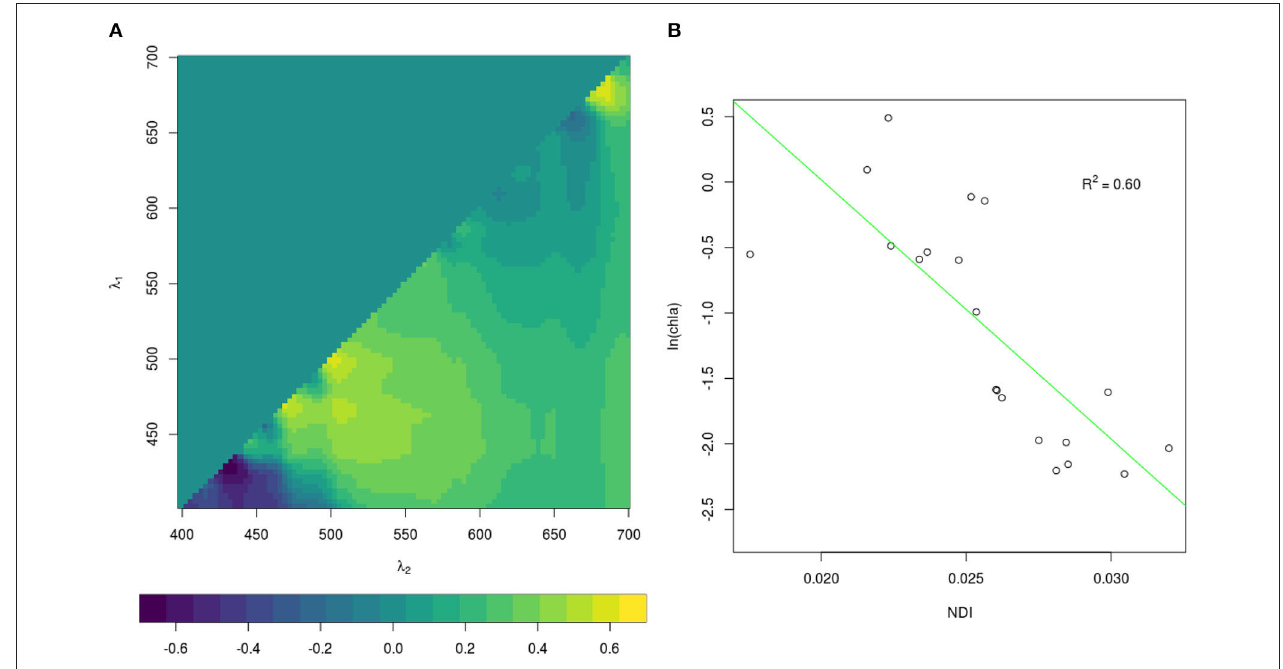
FIGURE 3 | Correlation surfaces (A) of normalized difference indices for integrated chl a for PS92 and PS106. λ 1 and λ 2 are wavelengths pairs. Relationship (B) between observed normalized difference indices and integrated chl a (dots). The green line represents the fitted relationship given by the algorithm c in Table 2